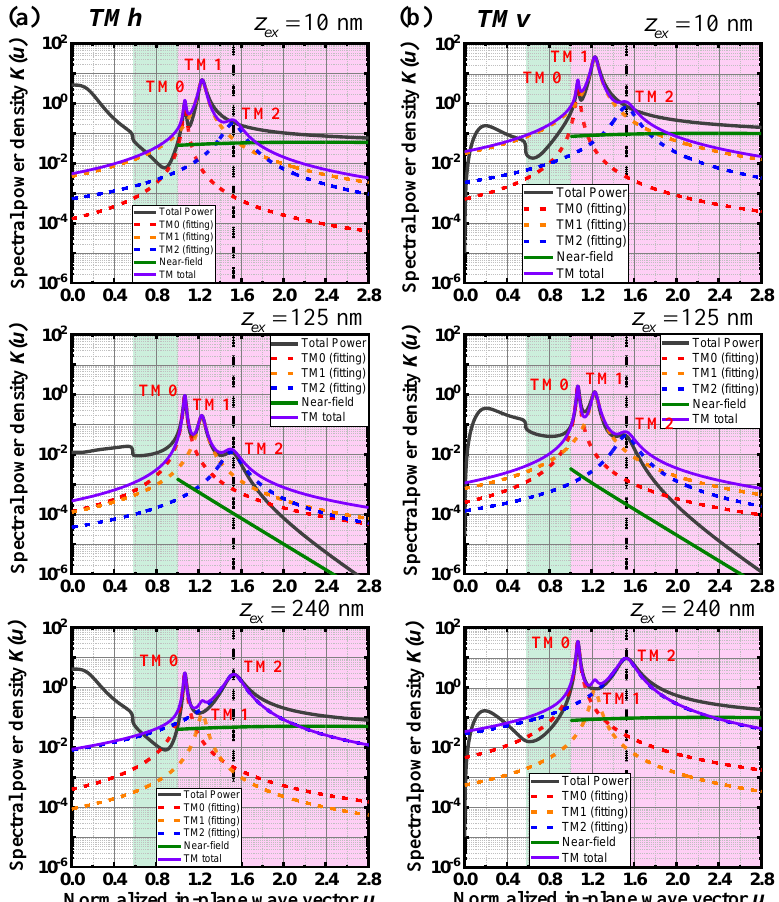
Figure 3. Spatial distributions of the normalized electric field intensities of TM modes confined in the top-emitting OLED. Three TM modes, having a typical characteristic of surface plasmon (SP) modes, are denoted as TM0, TM1, and TM2, which are named in the ascending order of the real part of their effective mode index shown in Table 1. The arrows indicate three dipole emitter posi- tions, which will be used in the calculation results of Figure 4.